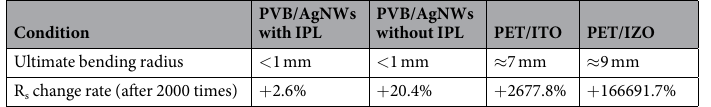
Table 2. Summary of bending characteristics of conductive films.